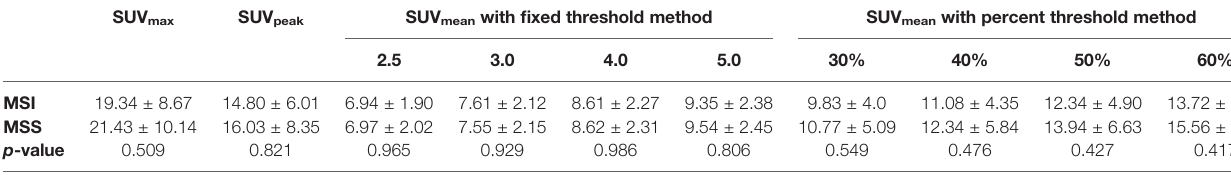
TABLE 2 | SUV measurements of CRC patients.